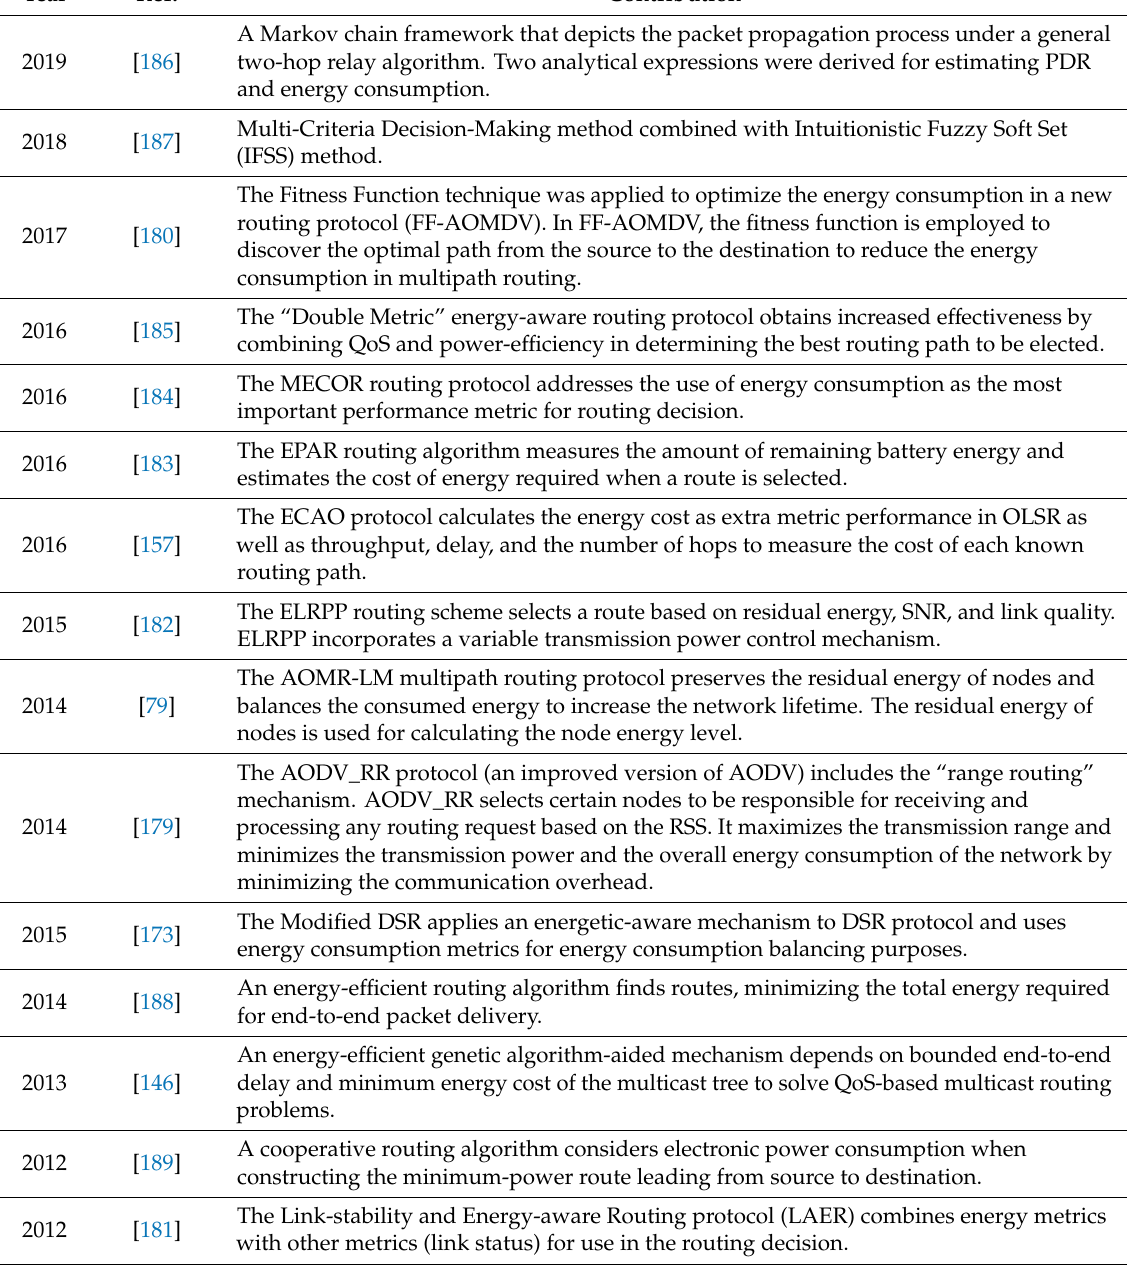
Table 2. Important works on transmission power control routing protocols for